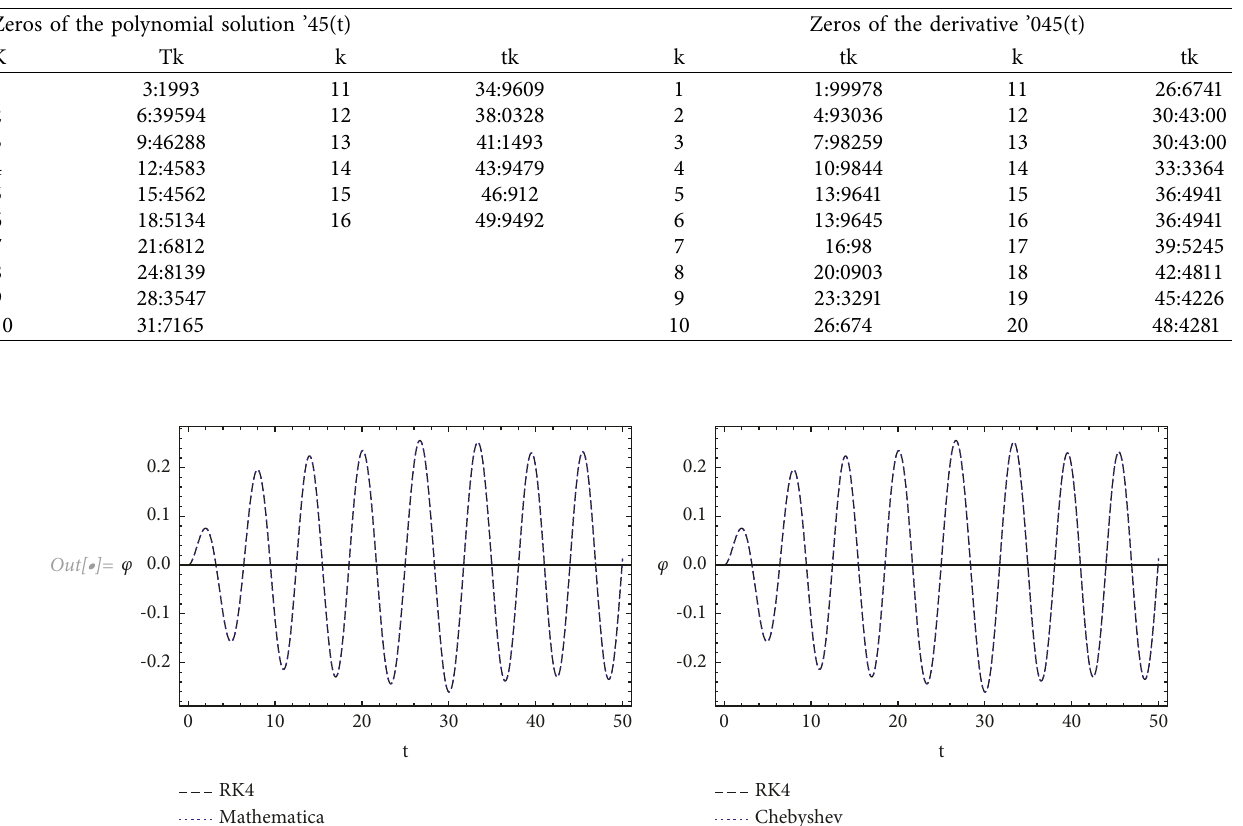
φ ,t plane and the cuts with the horizontal axis as well as the maxima and ( )